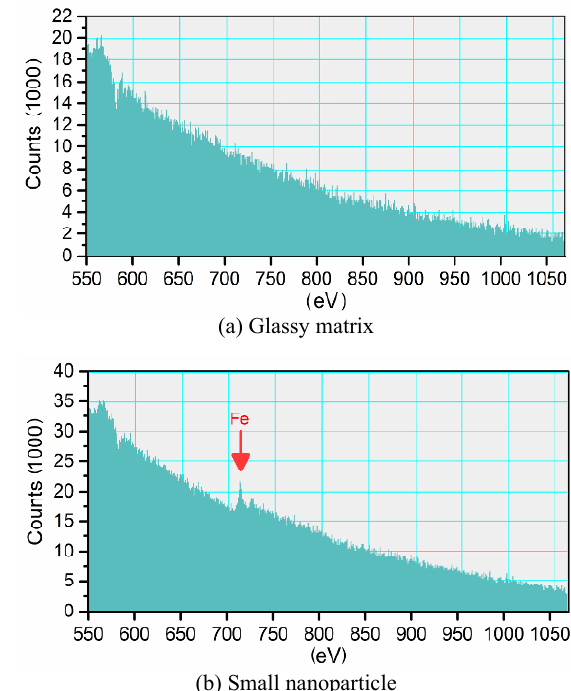
Fig. 2 HRTEM micrographs of the magnetite-based glass-ceramics obtained by crystallization of Fe-containing borosilicate glass melts (left panels) and the associated size distribution of the small nanoclusters (right panels).